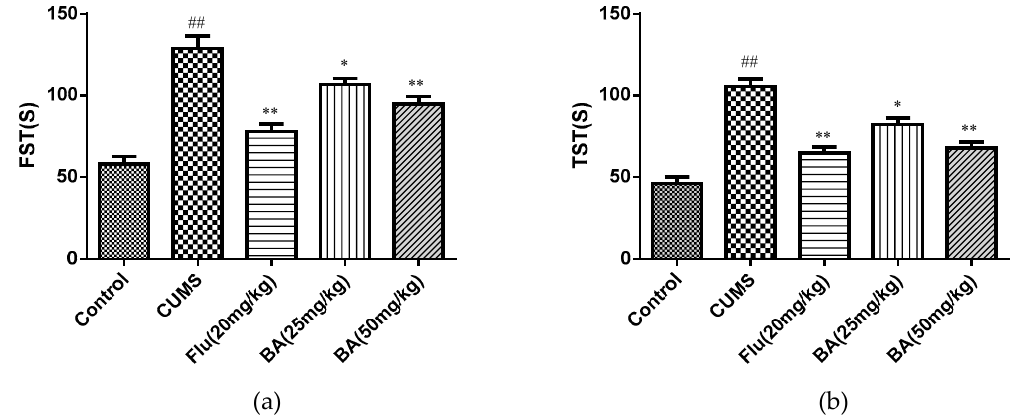
Figure 2. Effects of BA on ( a ) the tail suspension test (TST) and ( b ) the forced swim test (FST). Data were expressed as mean ± SEM ( n = 12). ## p < 0.01 vs. the control; * p < 0.05 and ** p < 0.01 vs. the CUMS group.